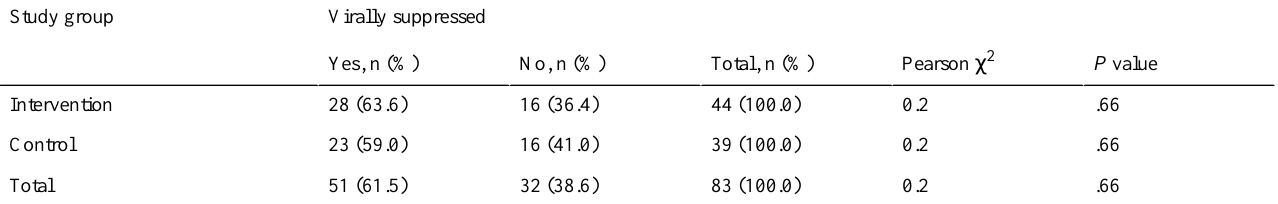
Table 3. Viral load suppression.